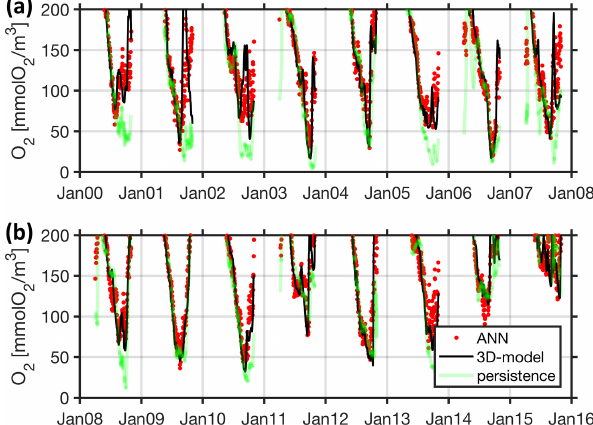
Figure 19. Walk-forward performance of ANN based on training and testing data (corresponding to 80% and 20% of the data shown here). The black line shows bottom oxygen concentrations at station Buoy 2a as simulated with the full-fledged and computationally ex- pensive 3-D coupled ocean circulation biogeochemical model. Each of the red dots denotes a respective biweekly walk-forward (com- putationally cheap) ANN forecast utilizing surface and bottom tem- peratures at station Boknis Eck only. For comparison, the green line features a naive biweekly persistency forecast based on bottom oxy- gen concentrations at station Boknis Eck .